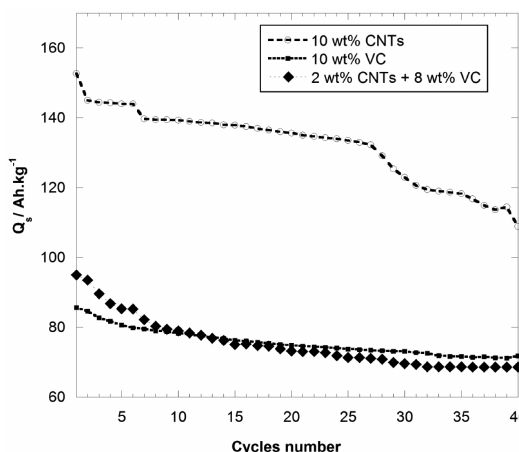
Figure 15. Cycling performance of nanocomposites electrodes at C/10 rate: LMO/VC (10 wt%), LMO/CNTs (2 wt%)/Carbon Vulcan (8 wt%) and LMO/CNTs (10